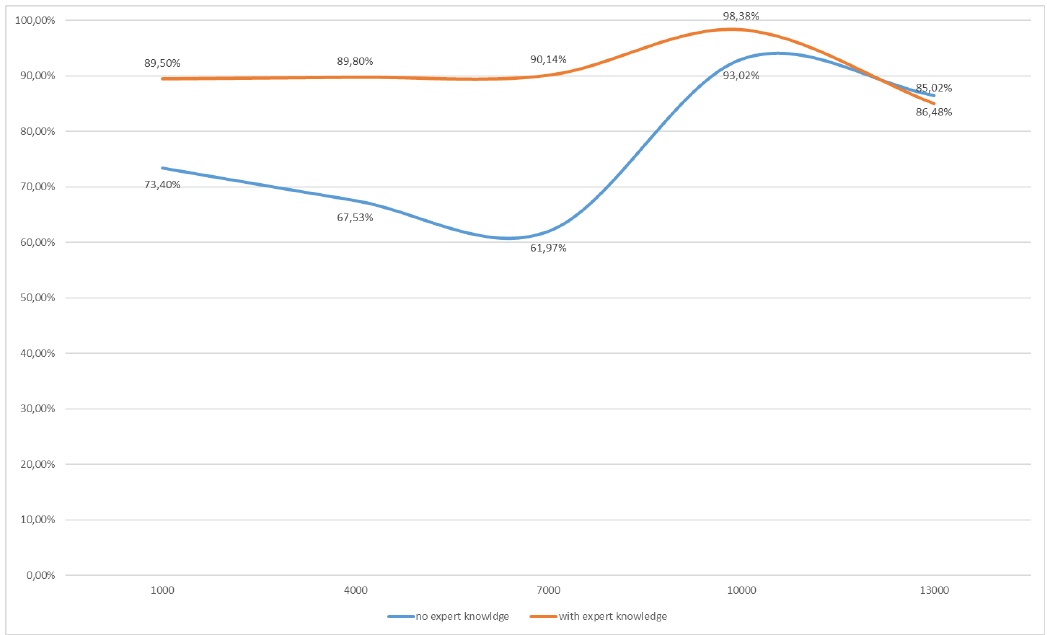
Figure 8. Test accuracies after training with expert knowledge (orange line) and without expert knowledge (blue